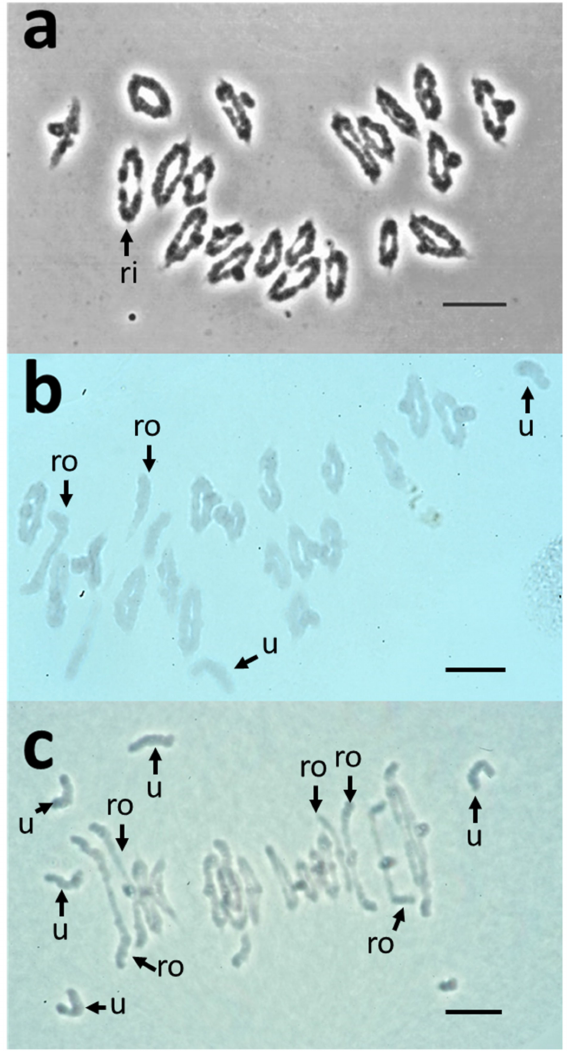
Figure 1. Meiotic behaviour of pollen mother cells (PMCs) of wild-type, Nulli 3B and ditelosomic Dt3BS Chinese Spring lines. Wild-type cells ( a ) exclusively show ring bivalents (ri) at metaphase I. Nullisomic 3B cells ( b ) exhibit a range of ring or rod (ro) bivalents and rare univalents (u), while ditelosomic Dt3BS cells ( c ) contain ring-bivalents and many rod bivalents (ro) and univalents (u), suggesting loss of obligate crossovers. Scale bar = 10 µ